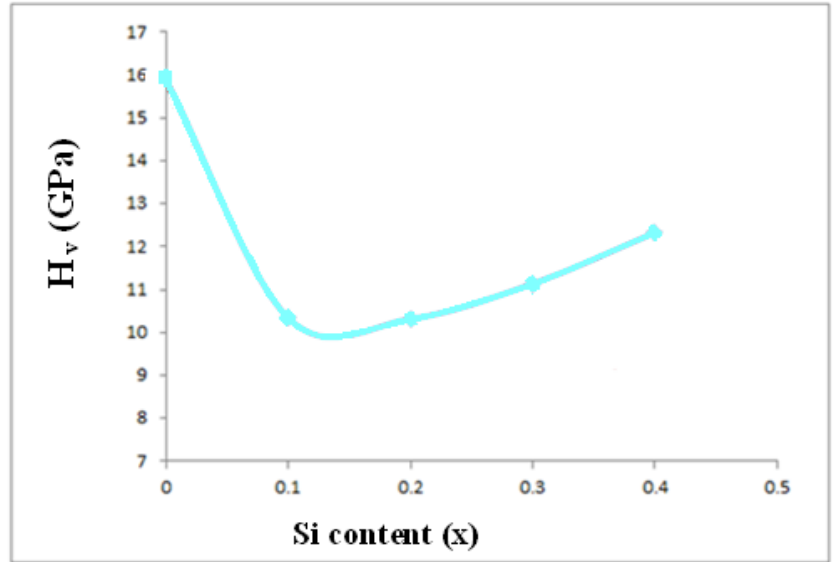
Fig. 7: Shows the micro hardness (Vickers hardness) of Mg